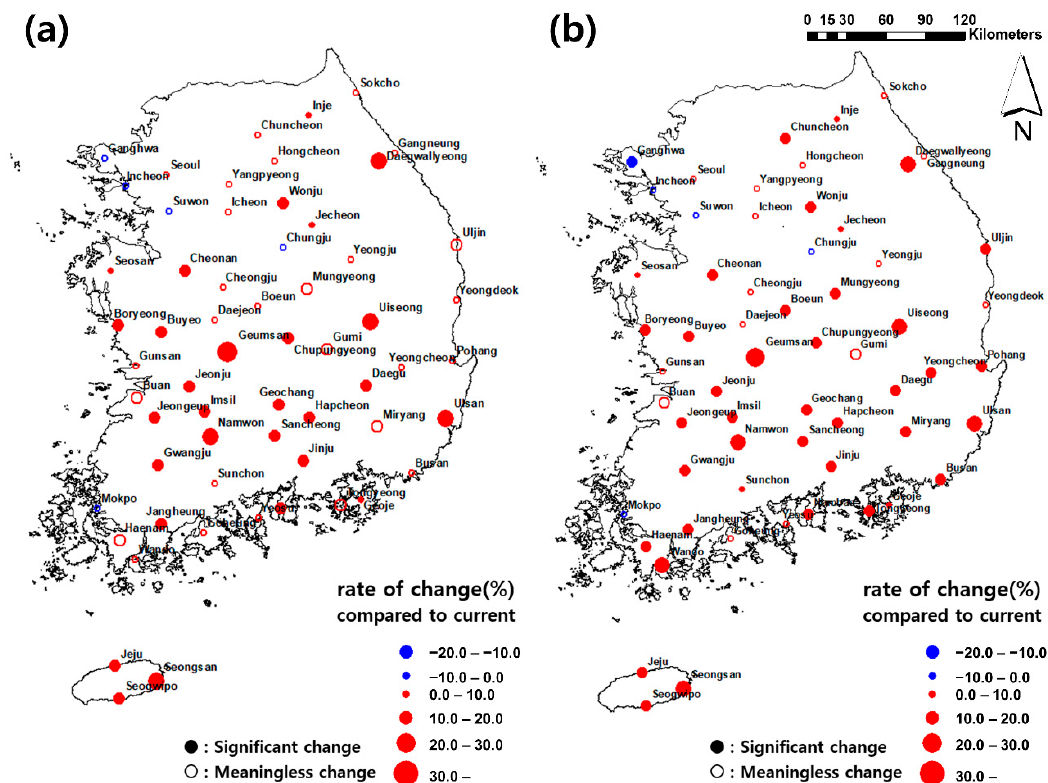
Figure 13. Significance of FEA of rates of change (duration 3 h and return period 30 years) ( a ) without considering uncertainty, and ( b ) with considering uncertainty. The red circles mean sites where future design rainfall intensity is higher than current design rainfall intensity, and the blue circles mean sites that decrease. Significant changes are indicated by filled circles, and meaningless changes are marked by empty circles. The diameter of the circle means the magnitude of the rate of change.